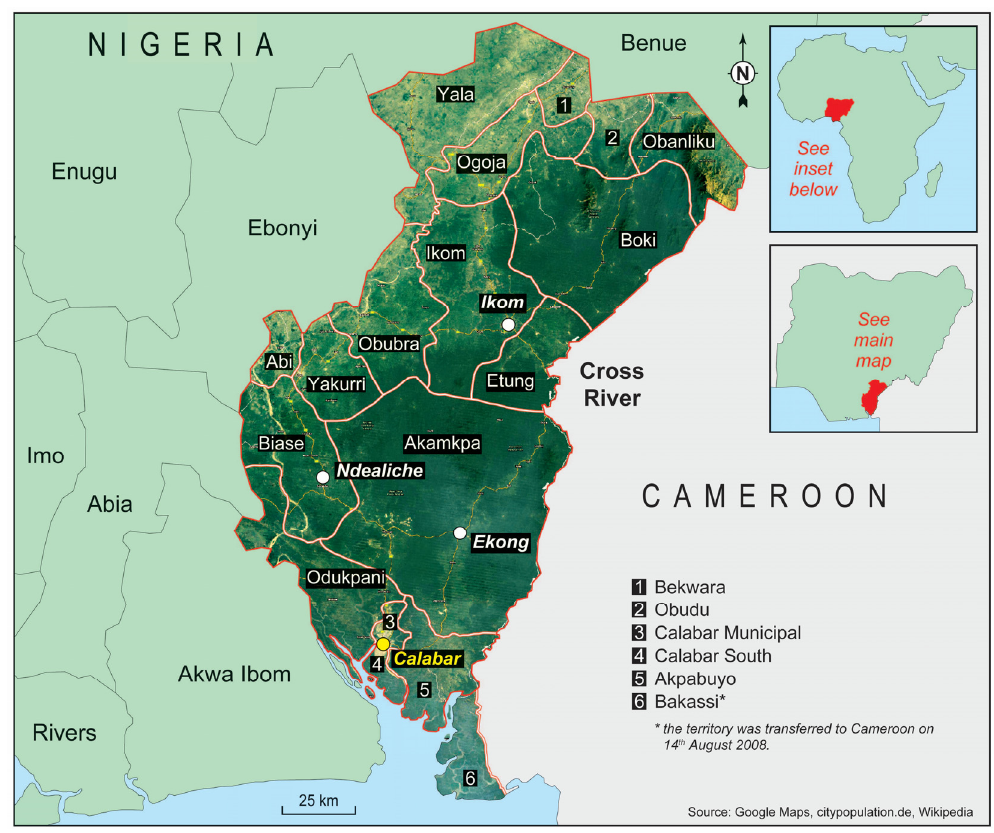
Figure 1. Map of Cross River State, Nigeria.